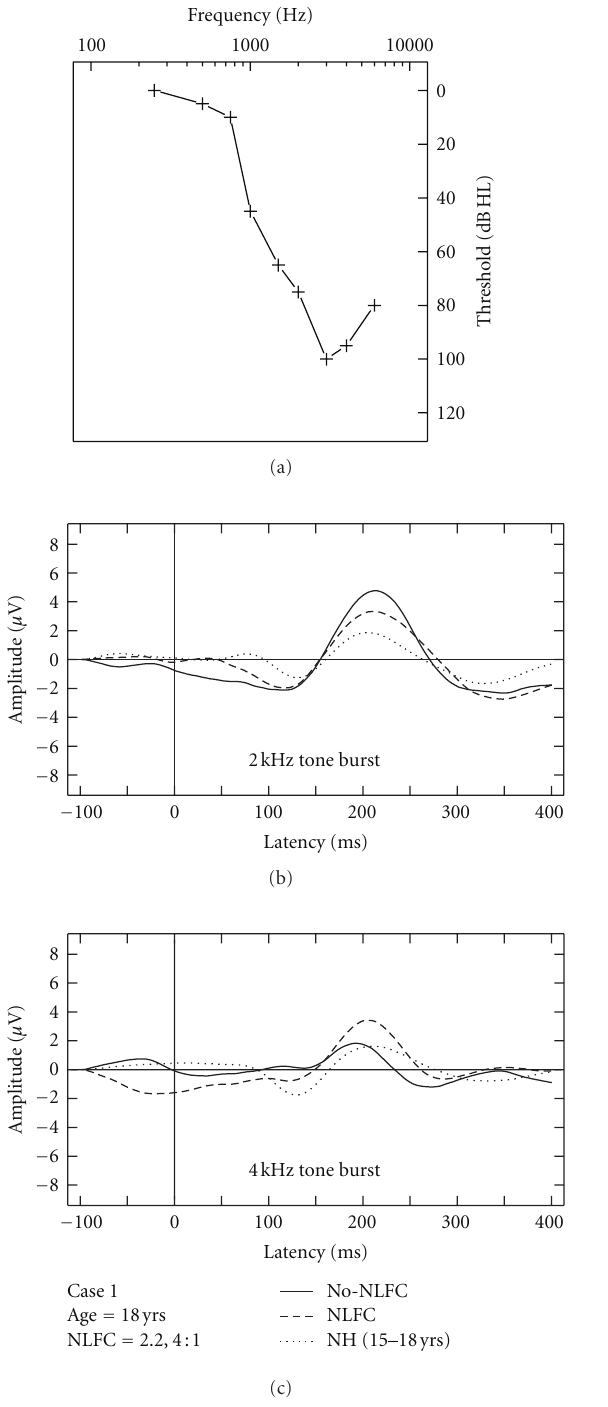
Figure 4: Case-specific grand mean CAEPs displayed across stimulus types and hearing aid conditions: no-NLFC (solid line), NLFC active (dashed line), and for each participant’s age-matched NH group (dotted line). Participant age and prescribed NLFC settings (cut-o ff frequency, compression ratio) are indicated in the legend. The top left corner pane displays test ear hearing thresholds, suspected cochlear dead regions (DR), and responses beyond the audiometric test